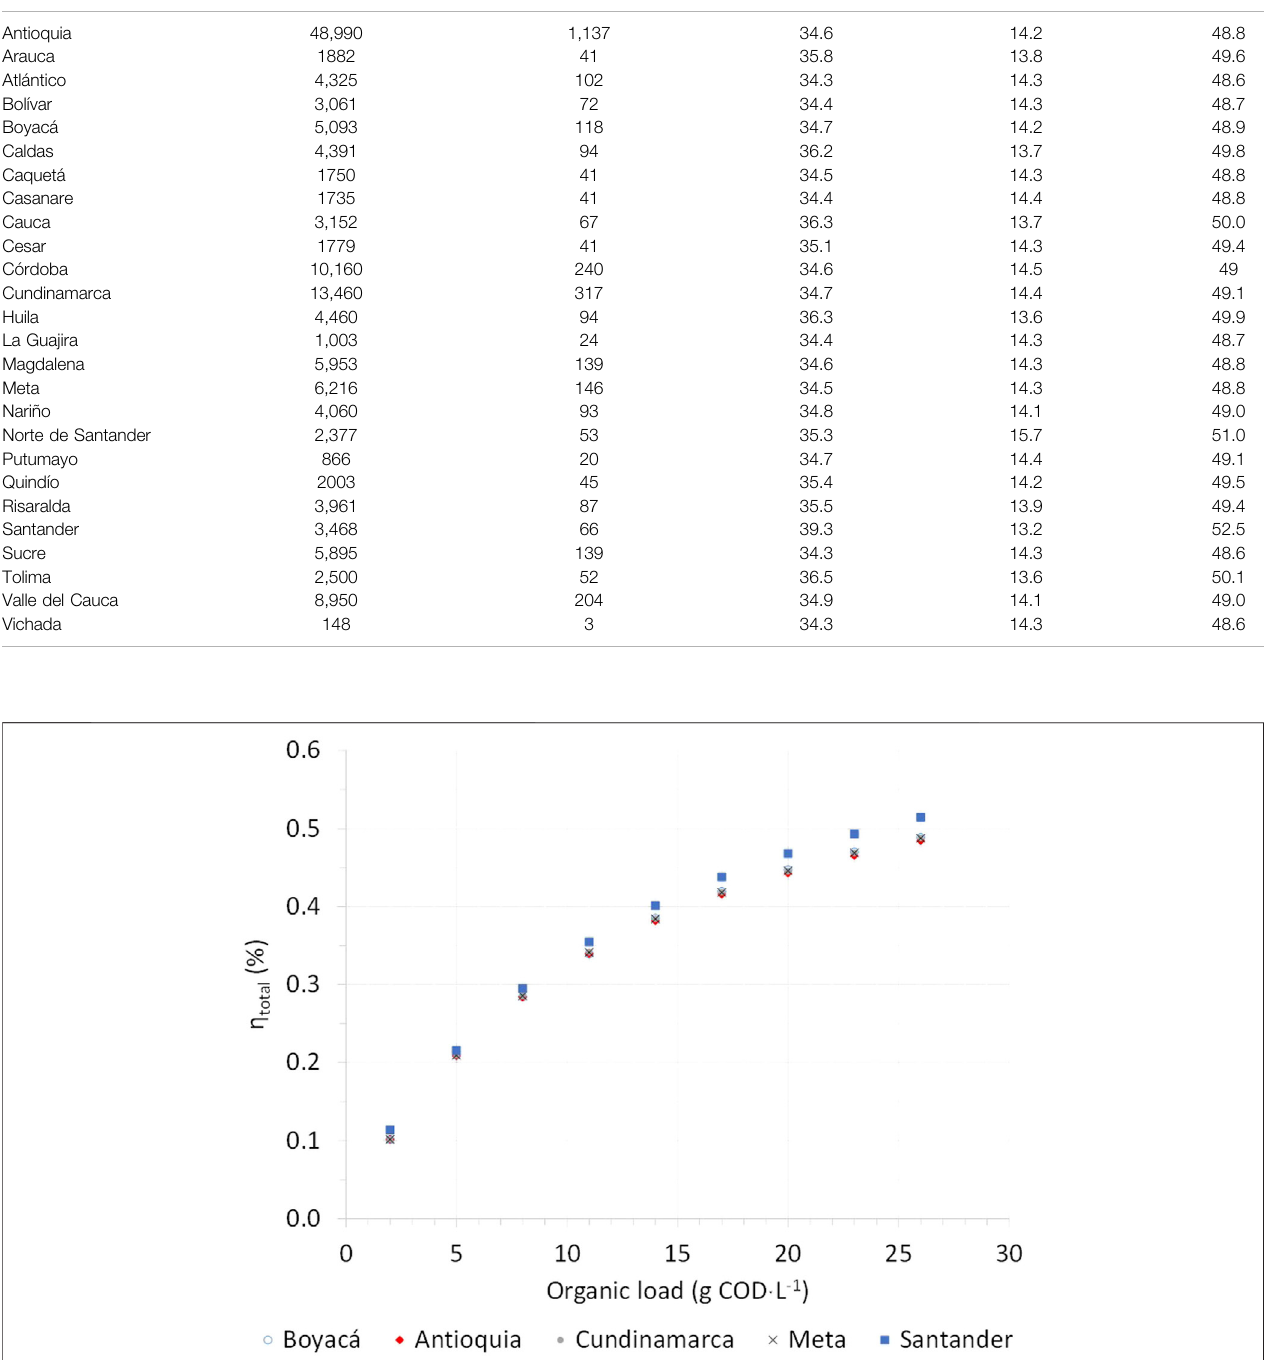
Frontiers in Energy Research |